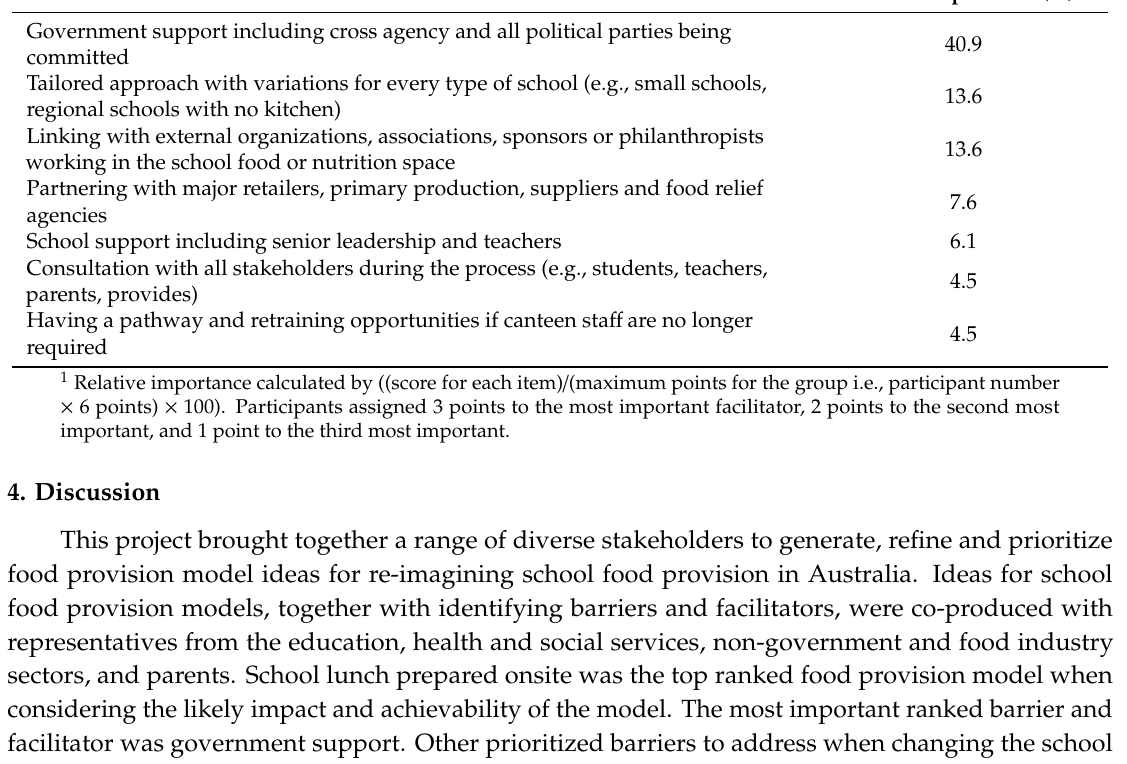
Table 4. Top five ranked facilitators to changing the school food system from the consensus workshop. Facilitator Relative Importance (%)